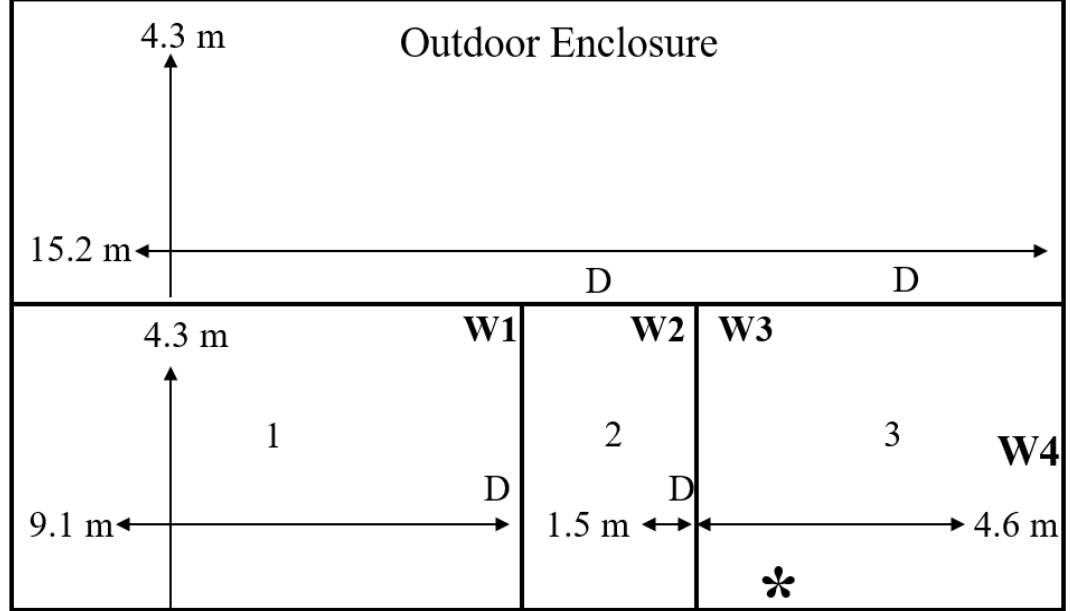
Diagram Showing the Three Indoor and One Outdoor Orangutan Enclosures